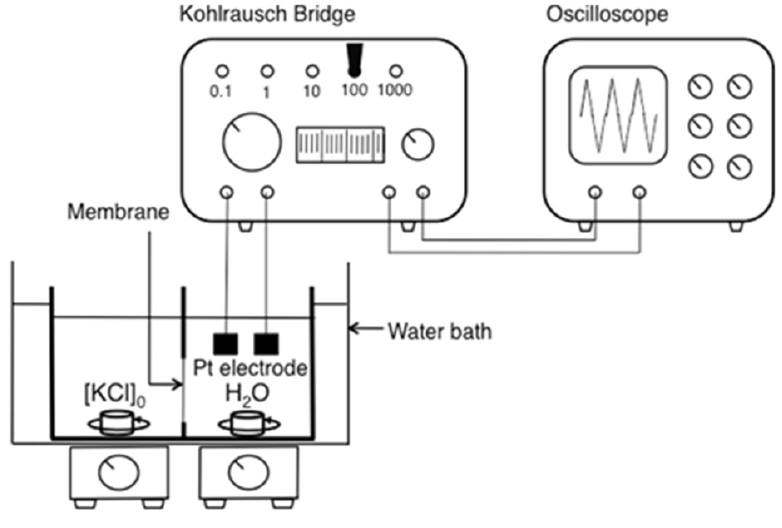
Figure 13. Schematic representation of the setup for alkali metal ion